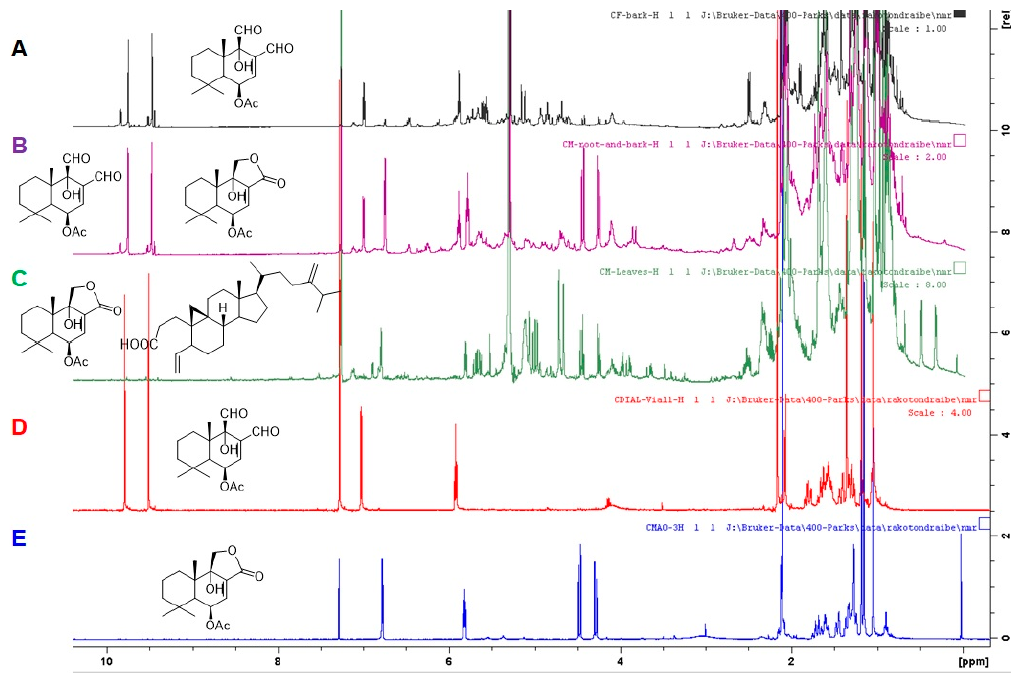
Figure 2. 1 H NMR spectra of Cinnamosma extracts, CDIAL ( 1 ), and CMOS ( 3 ). ( A ): Bark extract, ( B ): Root extract, ( C ): Leaf extract, ( D ): CDIAL and ( E ): CMOS.